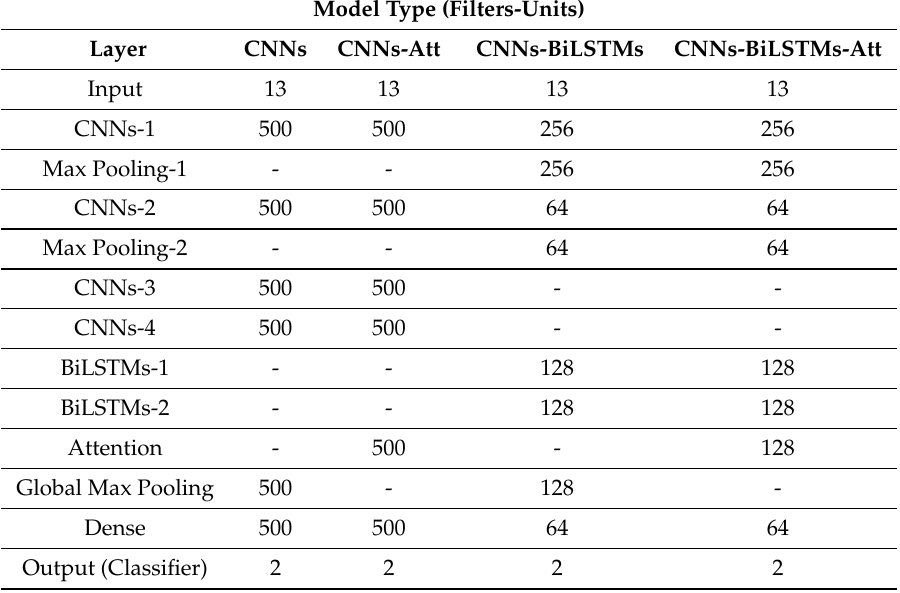
Convolutional neural network (CNN) vs CNN-long-short-term memory network (CNN-LSTM)